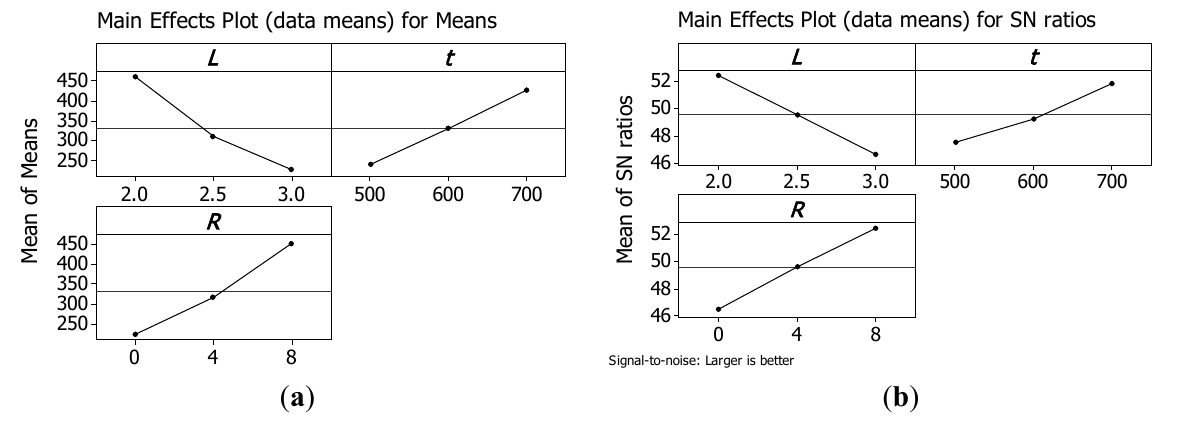
Figure 8. Main effects plot for means ( a ) and for S/N ratios ( b ) for peak strength.